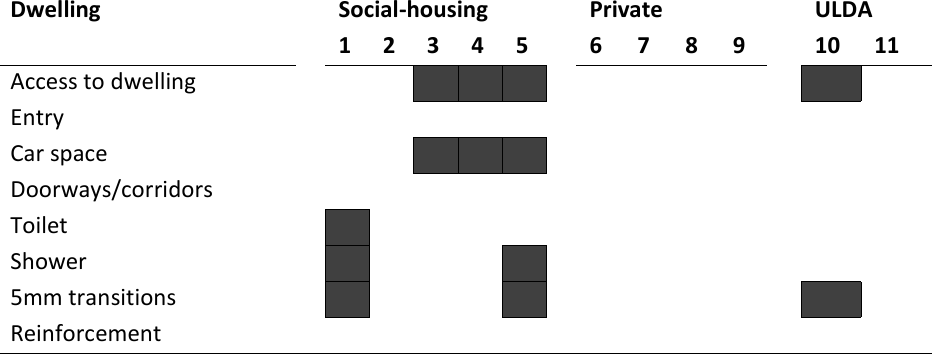
Table 6. Compliant features due to cost-effective practice.